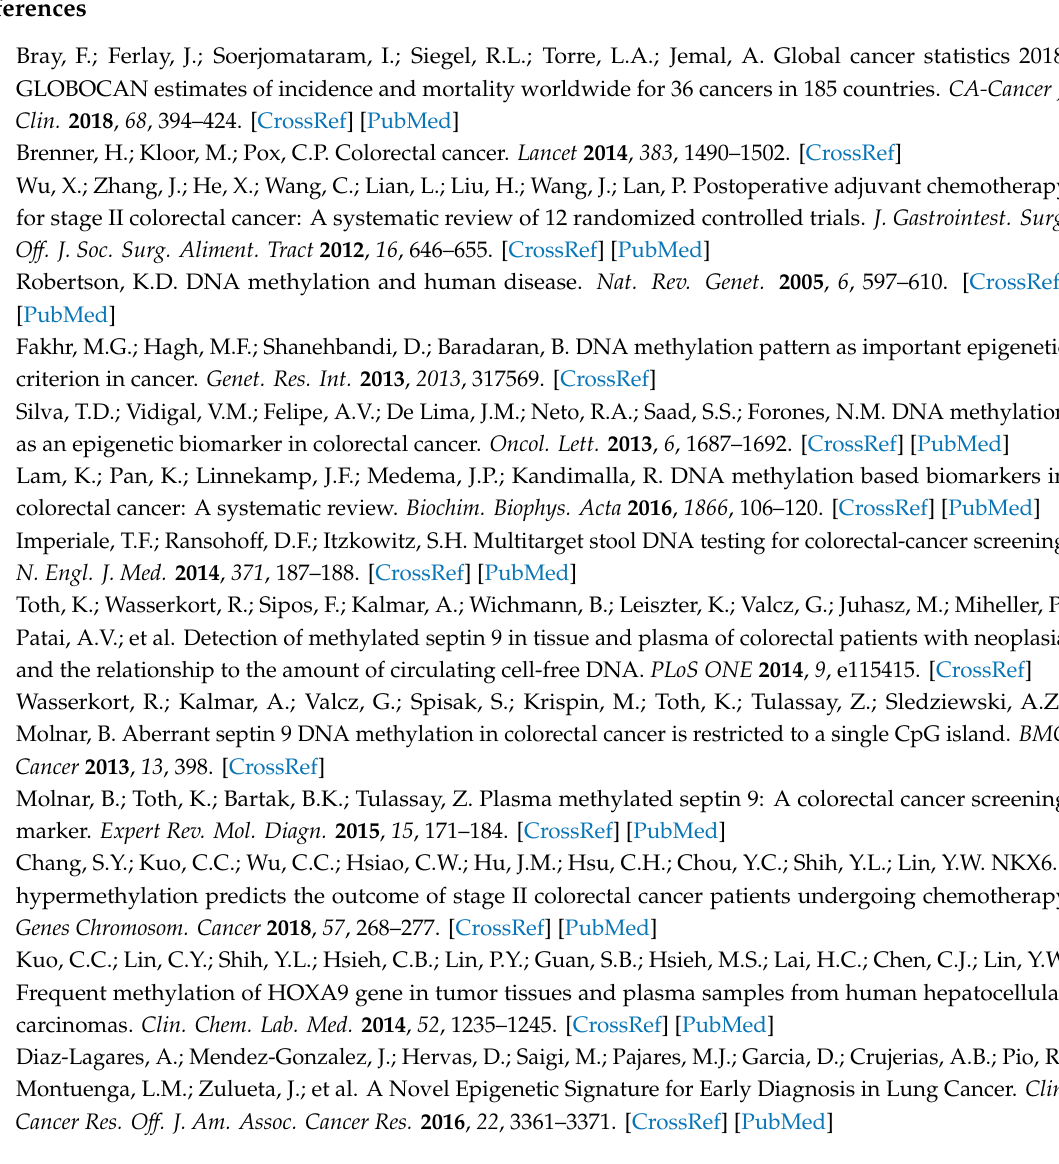
Table S5. Primer sequences used for